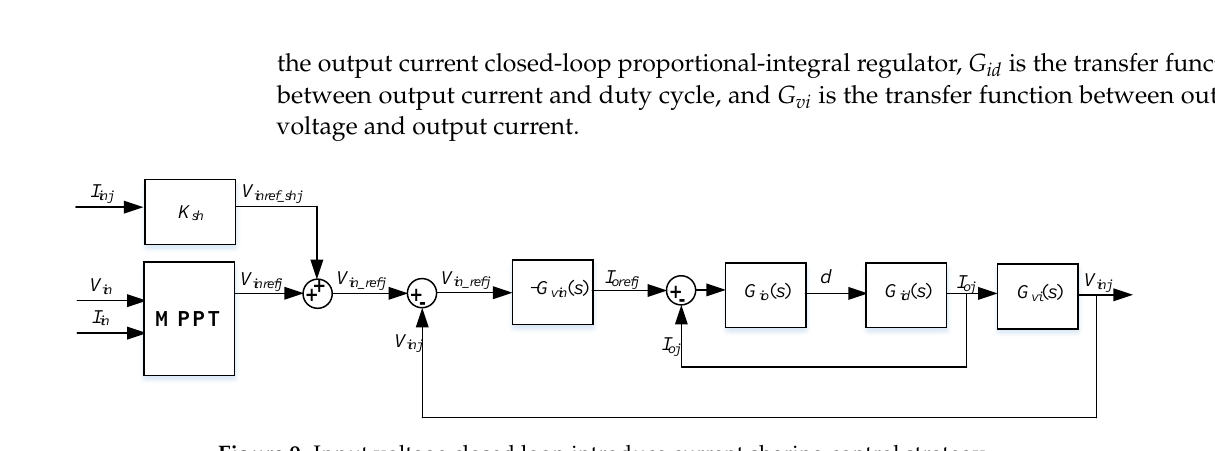
Figure 9. Input voltage closed loop introduce current sharing control strategy.